Question: Condense the content of this figure into a single sentence.
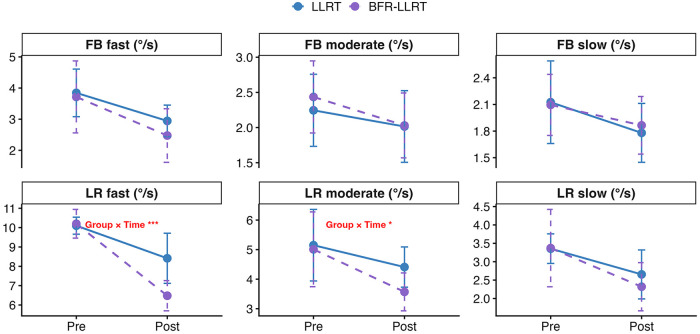
Answer: Changes in rhythmic weight-shift performance before and after the intervention. Panels represent anteroposterior and mediolateral directions at different movement speeds. Data are presented as mean ± SD for the LLRT and BFR-LLRT groups. Units are indicated in each panel. Red labels indicate conditions in which significant group × time interactions were observed. * p < 0.05; *** p < 0.001.